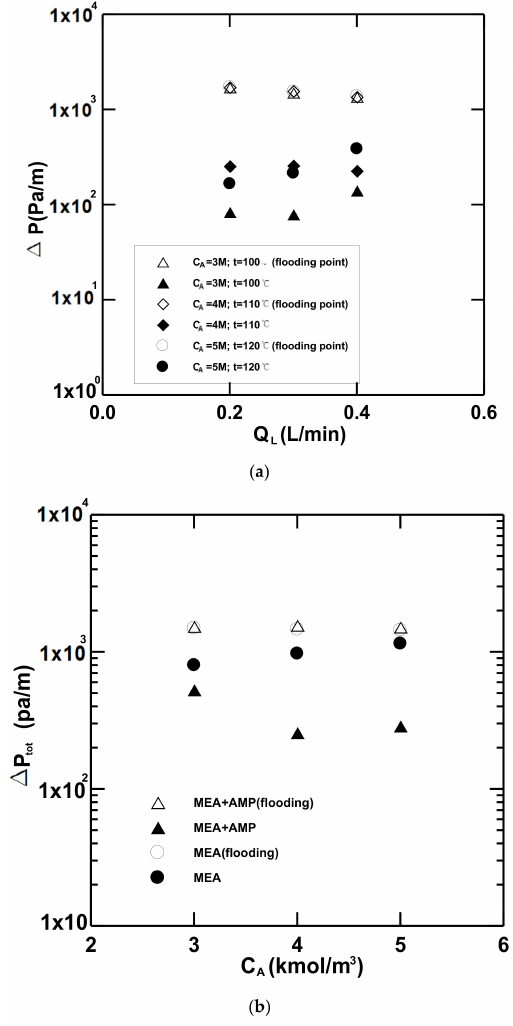
Figure 4. Effects of parameters on the pressure drops. ( a ) Effect of liquid flow rate on the pressure drop, ( b ) effect of concentration on the pressure drop.